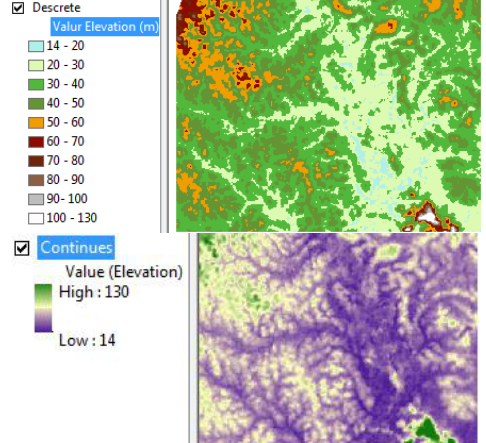
Figure 8. Type of spatial raster (a-descrete and b-continues)